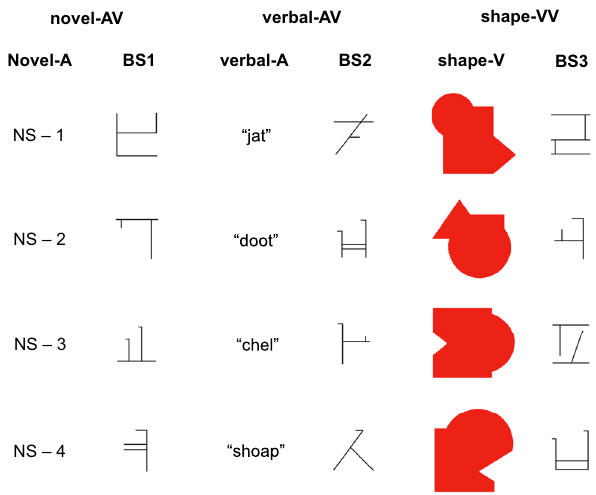
Figure 1. Auditory and visual stimuli of associative learning tasks. Auditory and visual stimuli for the novel sound-visual (novel- AV), the verbal-visual (verbal-AV), and the visual-visual (shape-VV) associative learning tasks.